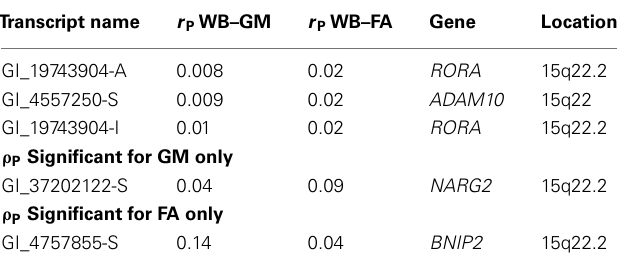
Table 8 | Correlation coefficient between the expression level and whole-brain average GM thickness and FA